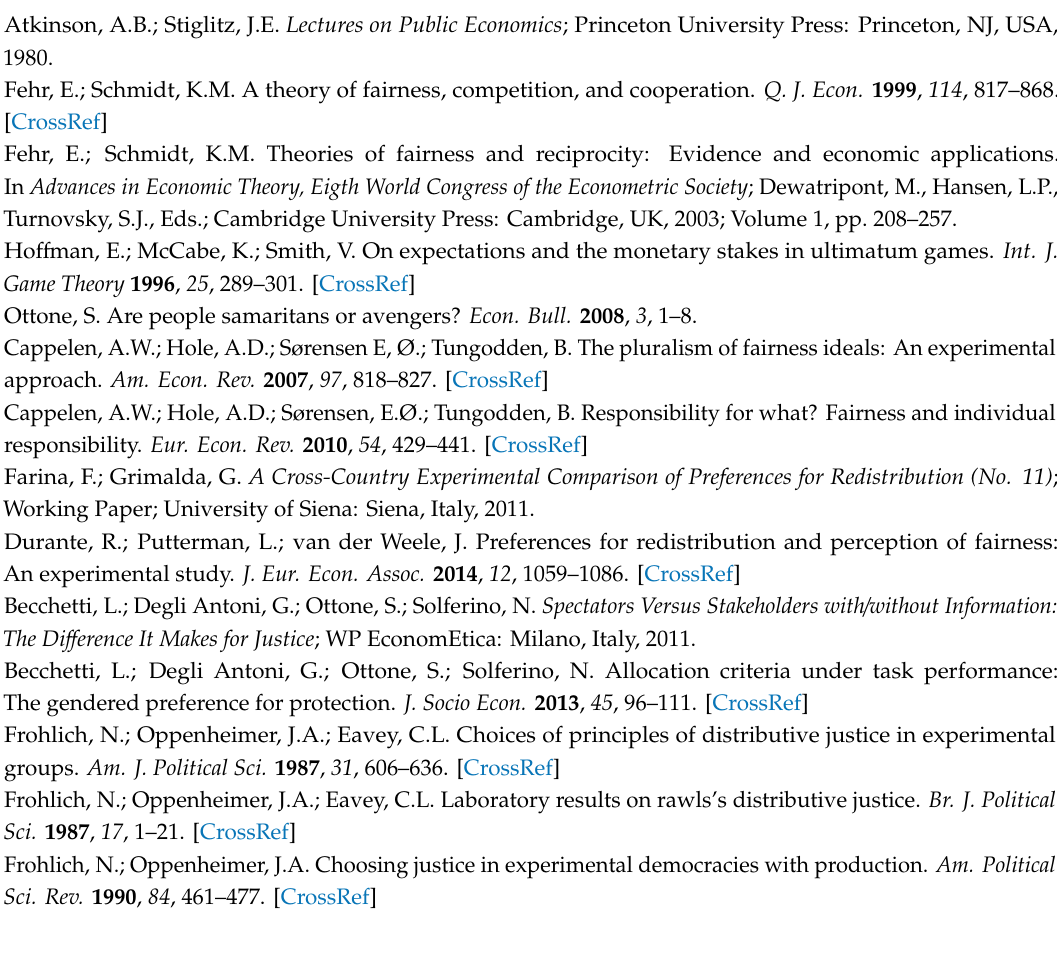
Figure S1: An example of Raven’s matrix. Determine the missing square, choosing among options A, B, C, D and E, Table S1: Preference distribution across the three contracts under the VOI condition, given the choice under the Table S3: Ordered probit regression (2)—marginal e ff ects. Dependent variable: CHOICE_NO_VOI, Table S4: Preferred contract under the VOI condition (percentages by expected category), Table S5: Preferred contract under the NO_VOI condition (percentages by category), Table S6: Less favored contract under the VOI condition (percentages by expected category), Table S7: Less favored contract under the NO_VOI condition (percentages by category), Table S8: Preferred contract (percentages by category) under the NO_VOI condition, by subjects preferring the Individualistic contract under the VOI condition, Table S9: Preferred contract (percentages by category) under the NO_VOI condition, by subjects preferring the Prioritarian contract under the VOI condition, Table S10: Probit regression (3)—marginal e ff ects. Dependent variable: SWITCH, Table S11: Preference distribution under both VOI and NO_VOI conditions (by middle class subjects who correctly predicted their status), Table S12: Ordered probit regression (4)—marginal e ff ects. Dependent variable: CHOICE_NO_VOI (for the middle class only), Table S13: Preferred contract by category under the NO_VOI condition (by the expected middle class subjects who under the VOI condition wrongly predicted their